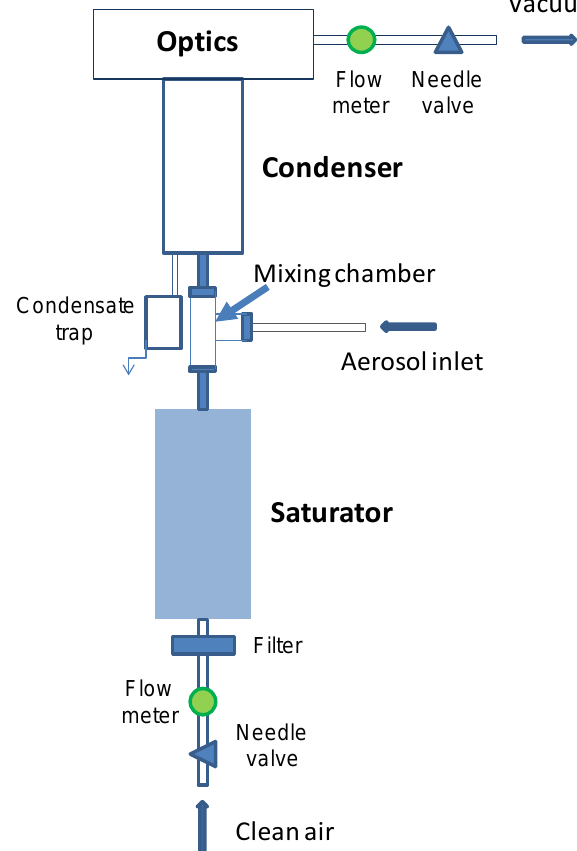
Fig. 1. Schematic of the new Fast CPC. A warm butanol-saturated air flow is mixed with the aerosol flow inside a Swagelok “T”. In the following condenser block the air is cooled, causing the required growth of aerosol particles to be counted inside the